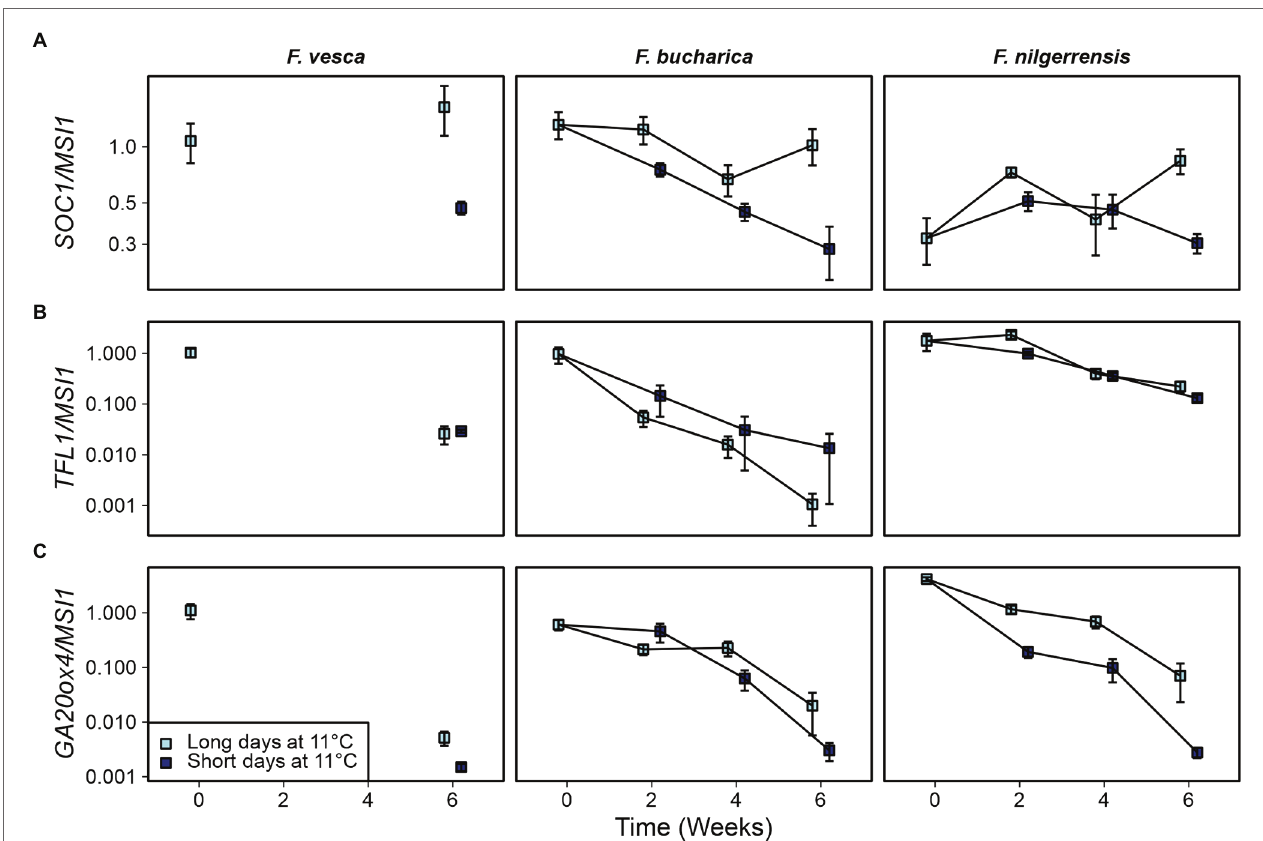
FIGURE 7 | Gene expression patterns in three diploid strawberry species grown in SDs or LDs at 11 ° C. SOC1 (A) , TFL1 (B) , and GA20ox4 expression (C) in shoot apical samples. Stolon-propagated plants were grown in LDs (18-h) or SDs (12-h) at 11 ° C, and shoot apical samples were collected at the beginning of the treatments, and 2, 4, and 6 weeks later. Week 0, Fragaria vesca samples were used as calibrator for relative expression analysis. Error bars represent the SEM ( n =